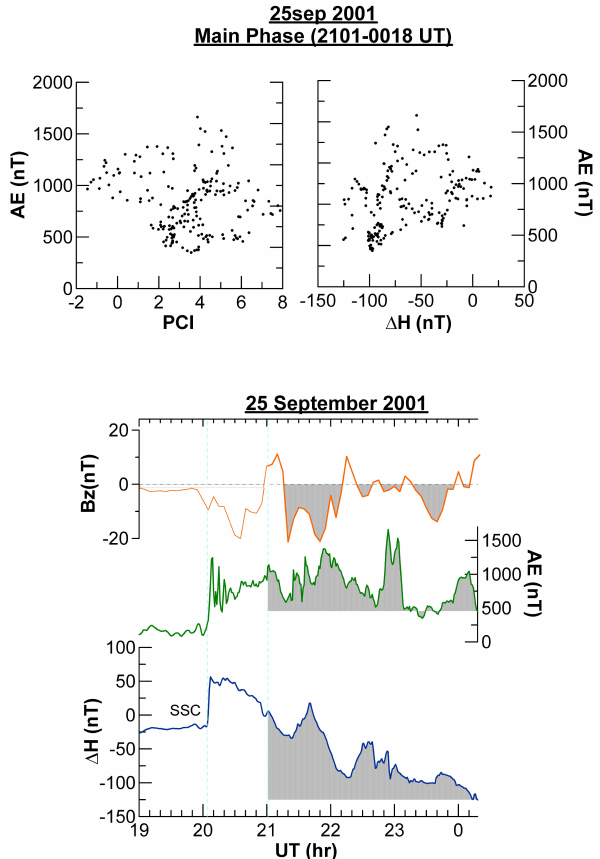
Fig. 12. Upper panel displays the correlations of polar cap magnetic activity ( PC ) index and low-latitude geomagnetic field 1H ABG with auroral electrojet ( AE ) index for 25 September 2001 for “ T 1” (21:01–00:18 UT) period. Bottom panel shows the variations of AE index and 1H ABG with corresponding IMF B z .